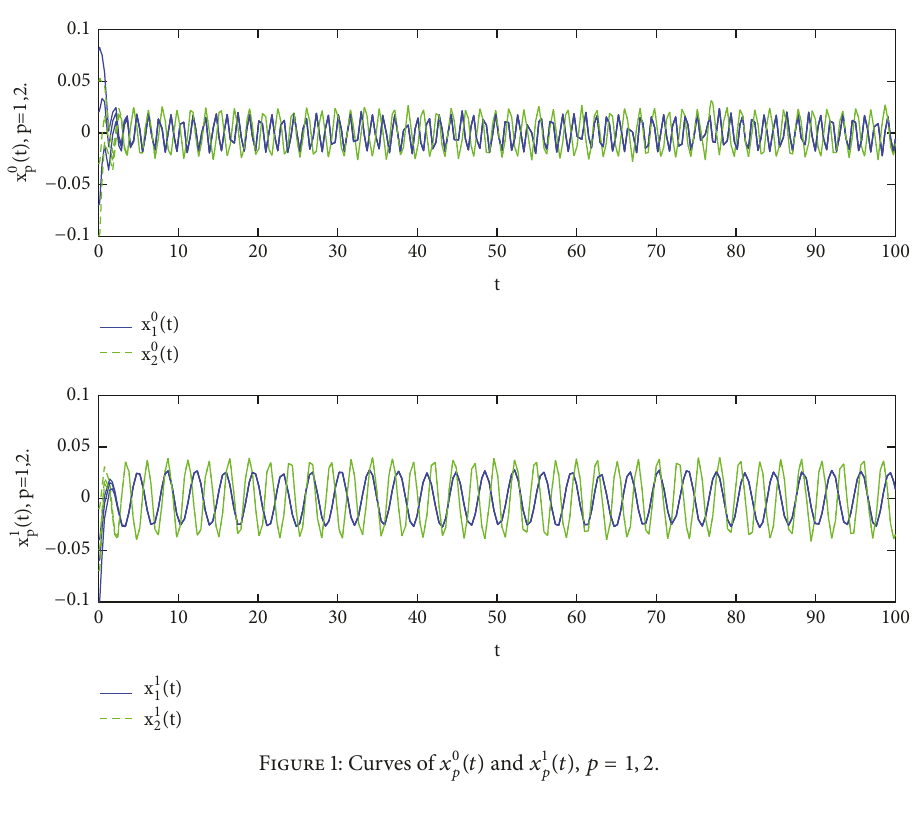
Figure 1: Curves of 𝑥 0 𝑝 (𝑡) and 𝑥 1 𝑝 (𝑡) , 𝑝 = 1, 2 .